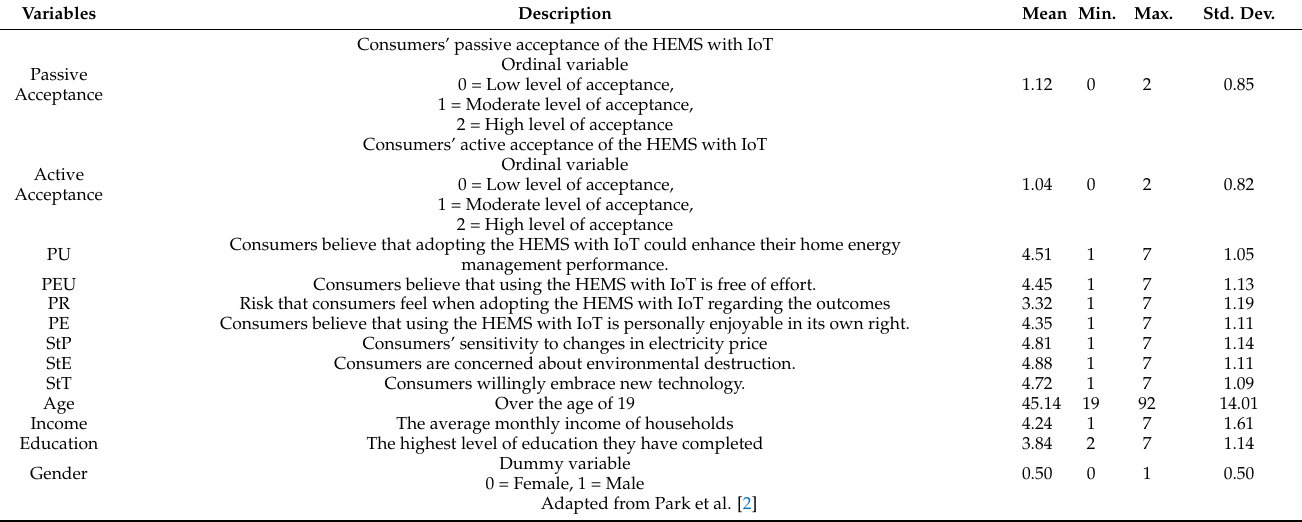
Table 1. Descriptive statistics of